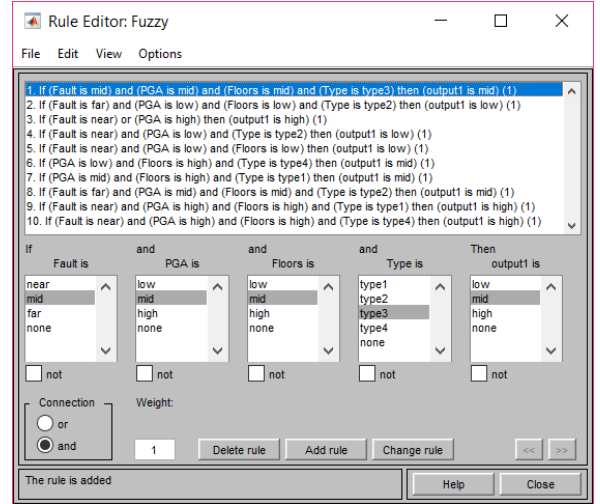
Figure 11. Employed fuzzy rules